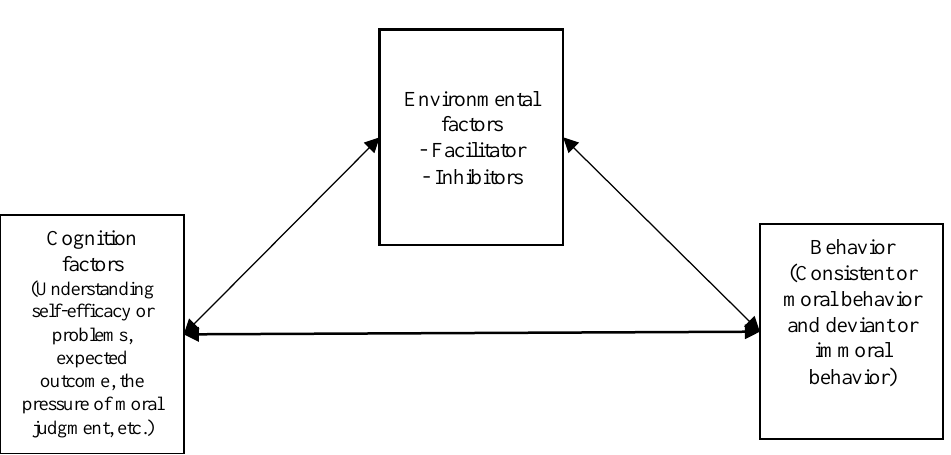
Figure 1. The structure of social cognition theory (Bandura,